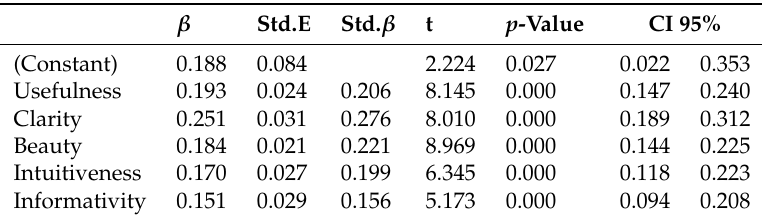
Table 5. Multiple-linear-regression analysis results with β coefficients, standardized β coefficient, their p -values, and their CI. β Std.E Std. β t p -Value CI 95% (Constant) 0.188 0.084 2.224 0.027 0.022 0.353 Usefulness